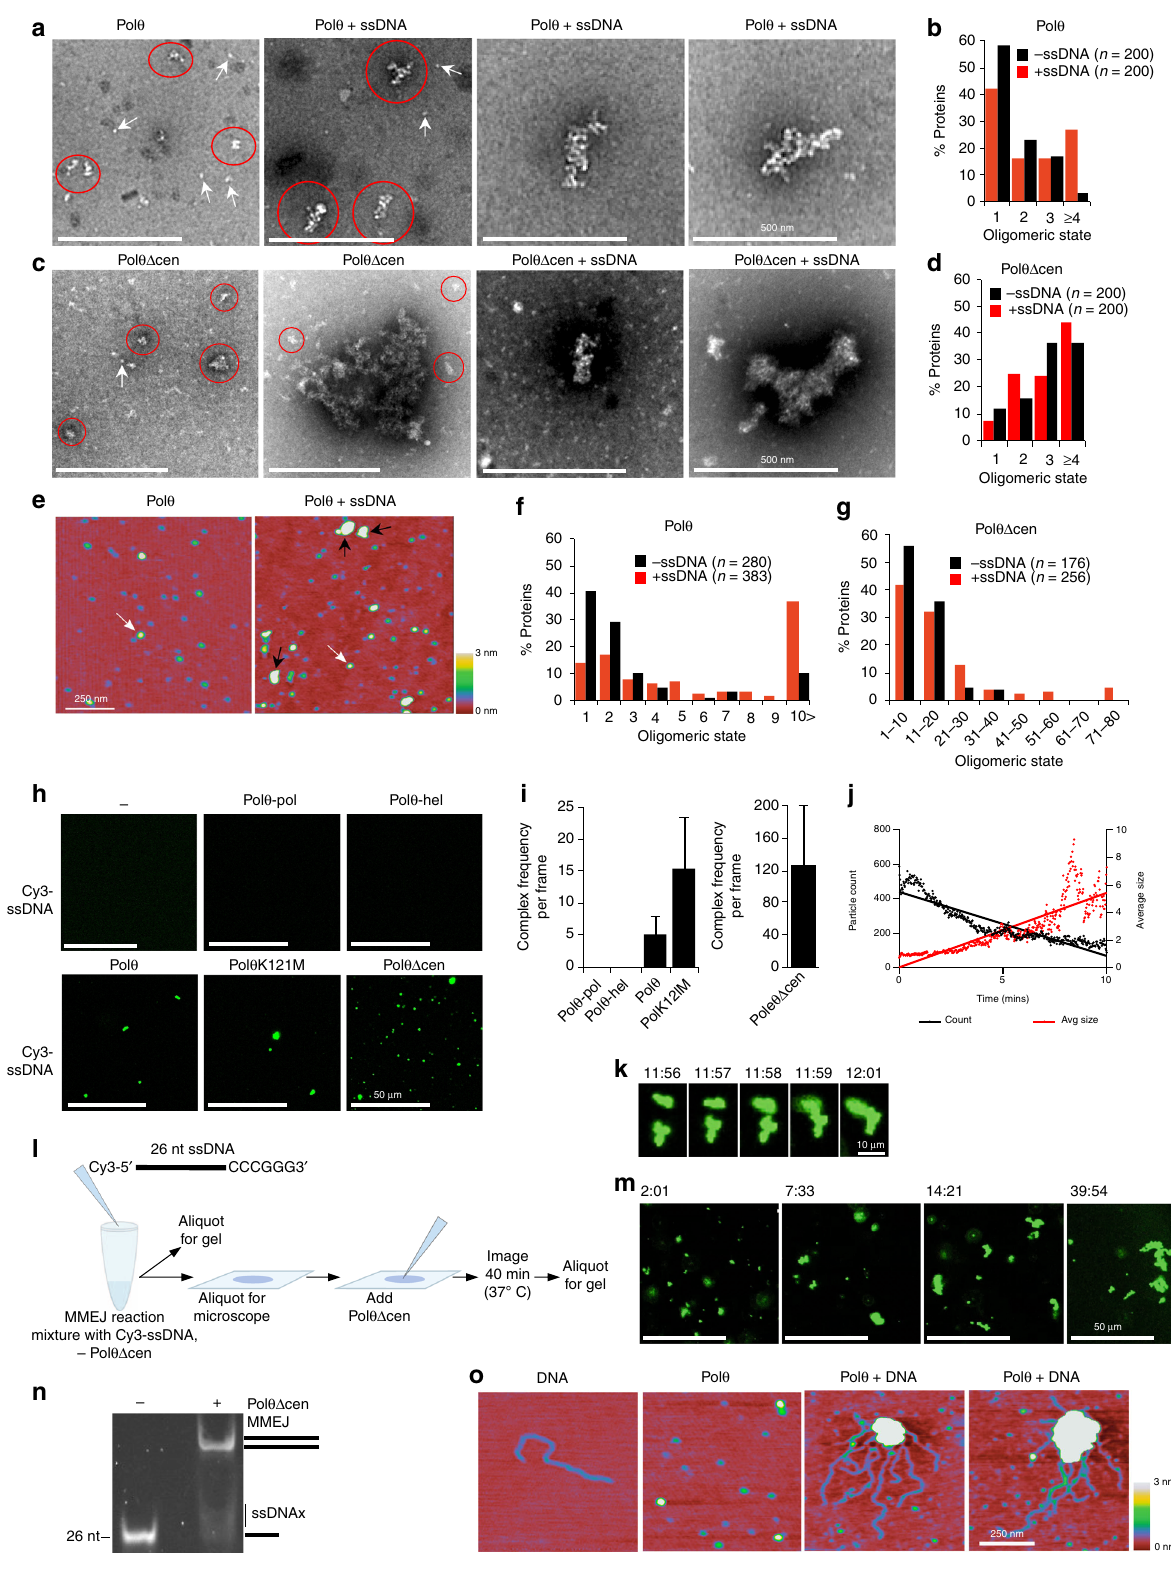
Pol θ -hel stimulates Pol θ -pol end-joining independently from its ATPase function. This supports the notion that Pol θ -hel upregulates Pol θ -pol MMEJ on long overhangs by simply binding ssDNA 5 ′ proximal to the polymerase where it suppresses unproductive intrastrand pairing and snap-back replication by Pol θ -pol (Fig. 7e, g). Pol θ -hel stimulation of Pol θ -pol MMEJ is